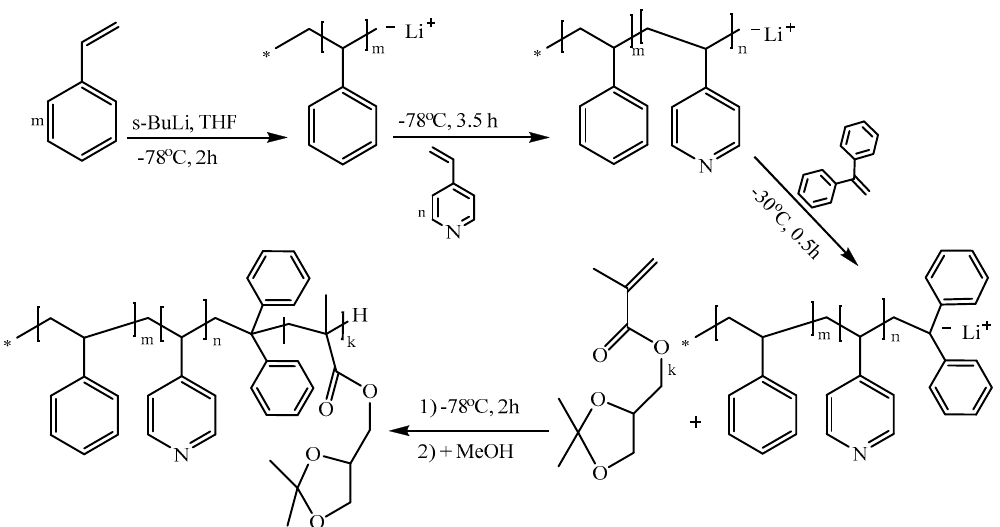
Figure 1. Synthetic route leading to PS- b -P4VP- b -PSMA by sequential anionic polymerization of styrene, 4-vinyl pyridine, and solketal methacrylate.